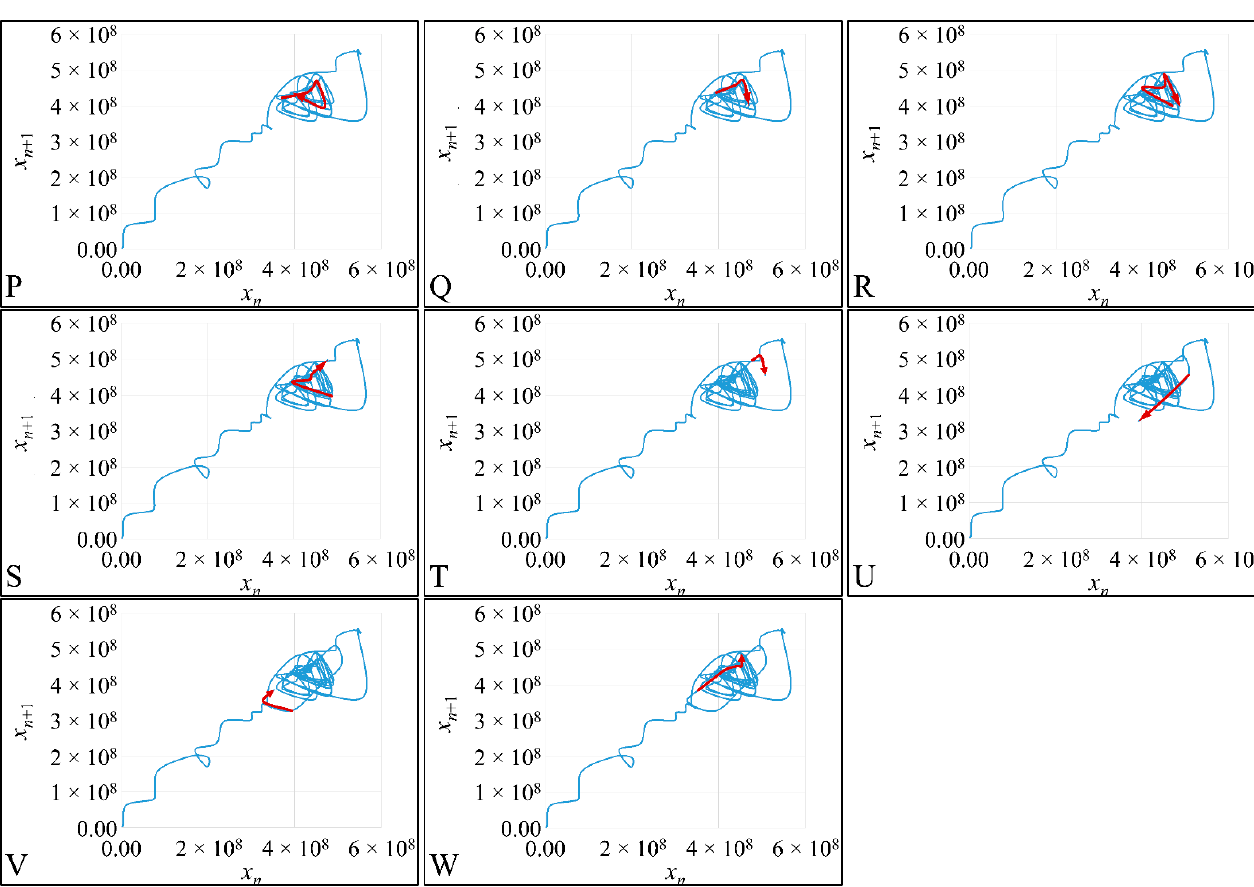
Figure 11. The phase-space steps of the experiment for x 0 = 20 cells/ μ L. The red arrows indicate the course of the trajectory step-by-step. The x -axis corresponds to the population of cells at time t and the y -axis corresponds to the population of cells at time t + 1. Each of the subfigures ( A – W ) presents the phase-space recurrences from the first ( A ) to the 23rd ( W ).